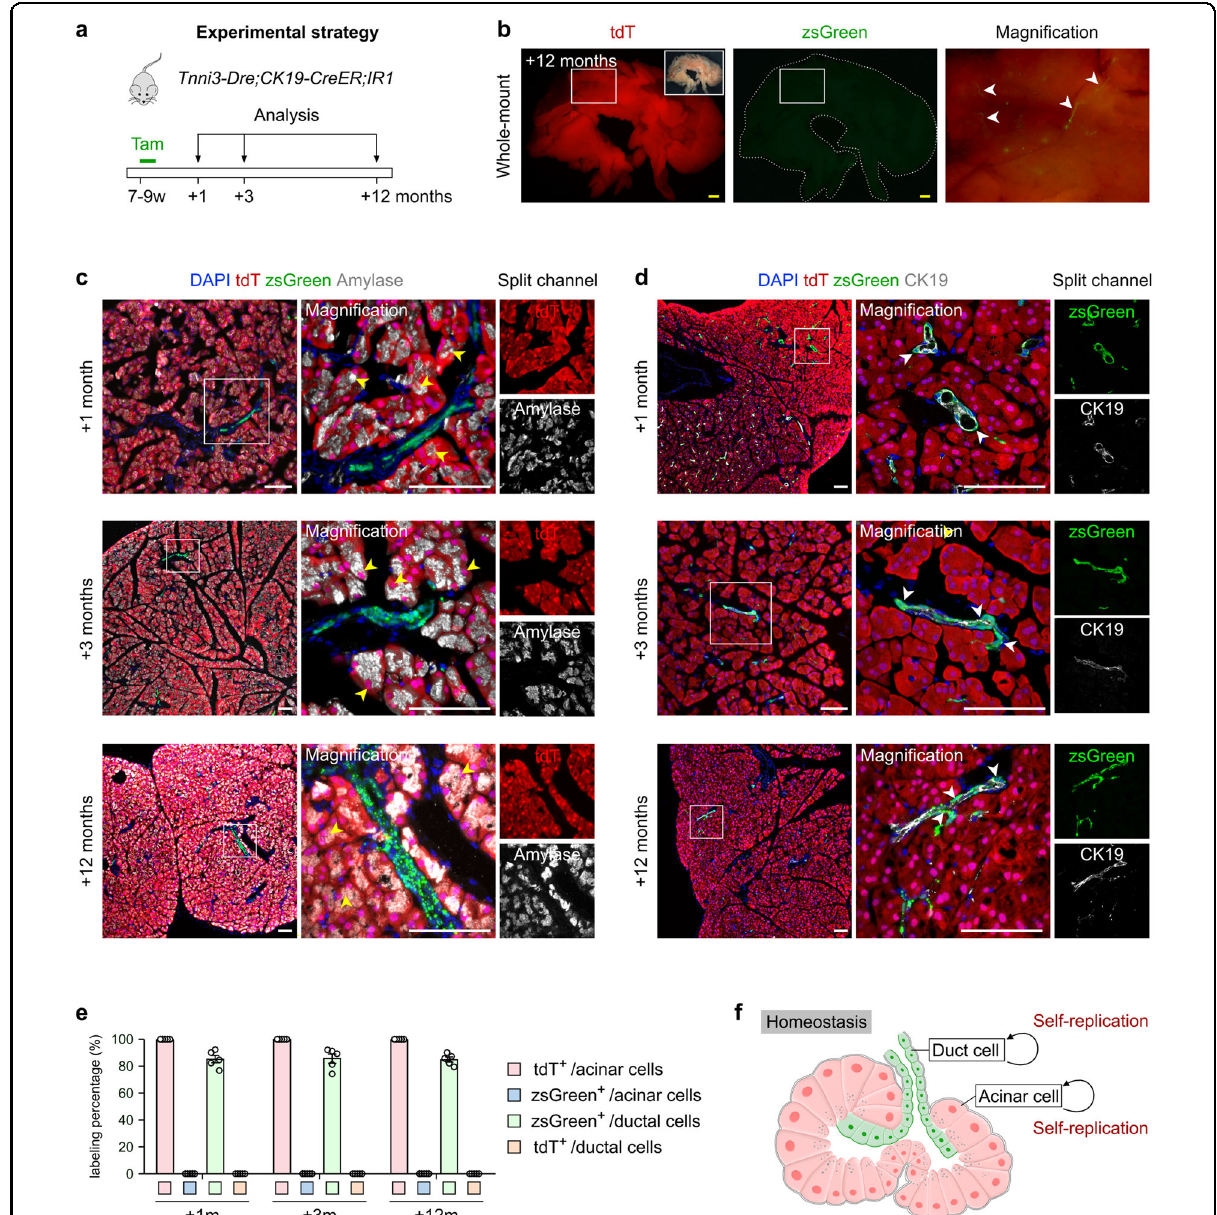
Fig. 2 The pancreas does not exhibit lineage transdifferentiation between ductal and acinar cells during physiology. a Schematic diagram illustrating the experimental strategy for Tam-induced lineage tracing and analysis. b Whole-mount bright- fi eld and fl uorescent images for zsGreen and tdT expression in pancreas from Tnni3-Dre;CK19-CreER;IR1 mice after 12 months of tracing. c , d Immunostaining for tdT, zsGreen and Amylase ( c ) or CK19 ( d ) on pancreatic sections collected from indicated time points. Yellow arrowheads, tdT + acinar cells. White arrowheads, zsGreen + ductal cells. e Quanti fi cation of the percentages of acinar cells expressing tdT or zsGreen and ductal cells expressing tdT or zsGreen from Tnni3-Dre;CK19- CreER;IR1 mice at indicated time points. Data are means ± SEM; n = 5. f Schematic diagram illustrating that the pancreatic exocrine gland does not exhibit lineage transdifferentiation during homeostasis. Scale bars, yellow, 1 mm; white,100 μ m. Each image is representative of 5 individual